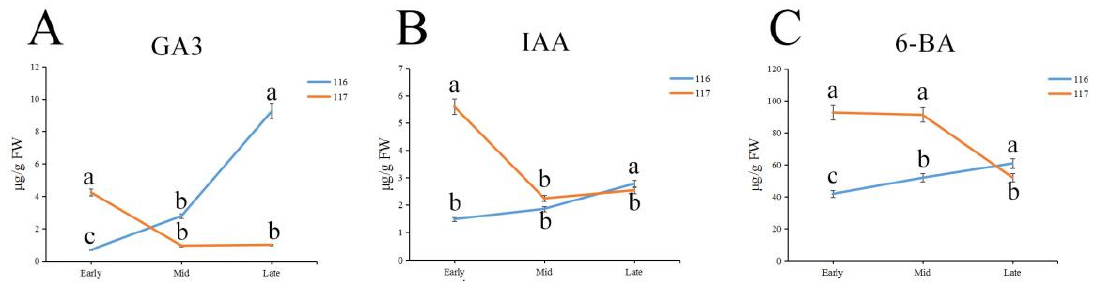
Figure 11. The levels of GA3 ( A ), IAA ( B ) and 6-BA ( C ) in inflorescence meristems of ‘116’ and ‘117’ plants. Each bar represents the mean ± SD and different lowercase letters indicate significant differences ( t -test, p ≤ 0.05).